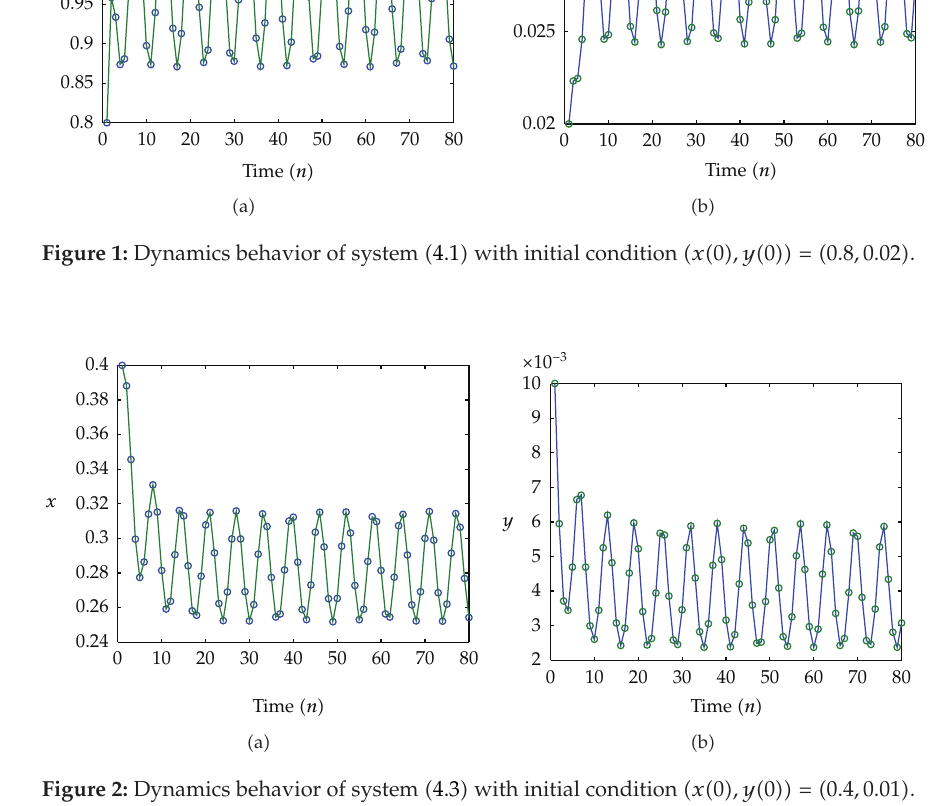
Figure 2: Dynamics behavior of system (cid:4) 4.3 (cid:5) with initial condition (cid:4) x (cid:4) 0 (cid:5) ,y (cid:4) 0 (cid:5)(cid:5) (cid:8) (cid:4) 0 . 4 , 0 . 01 (cid:5)